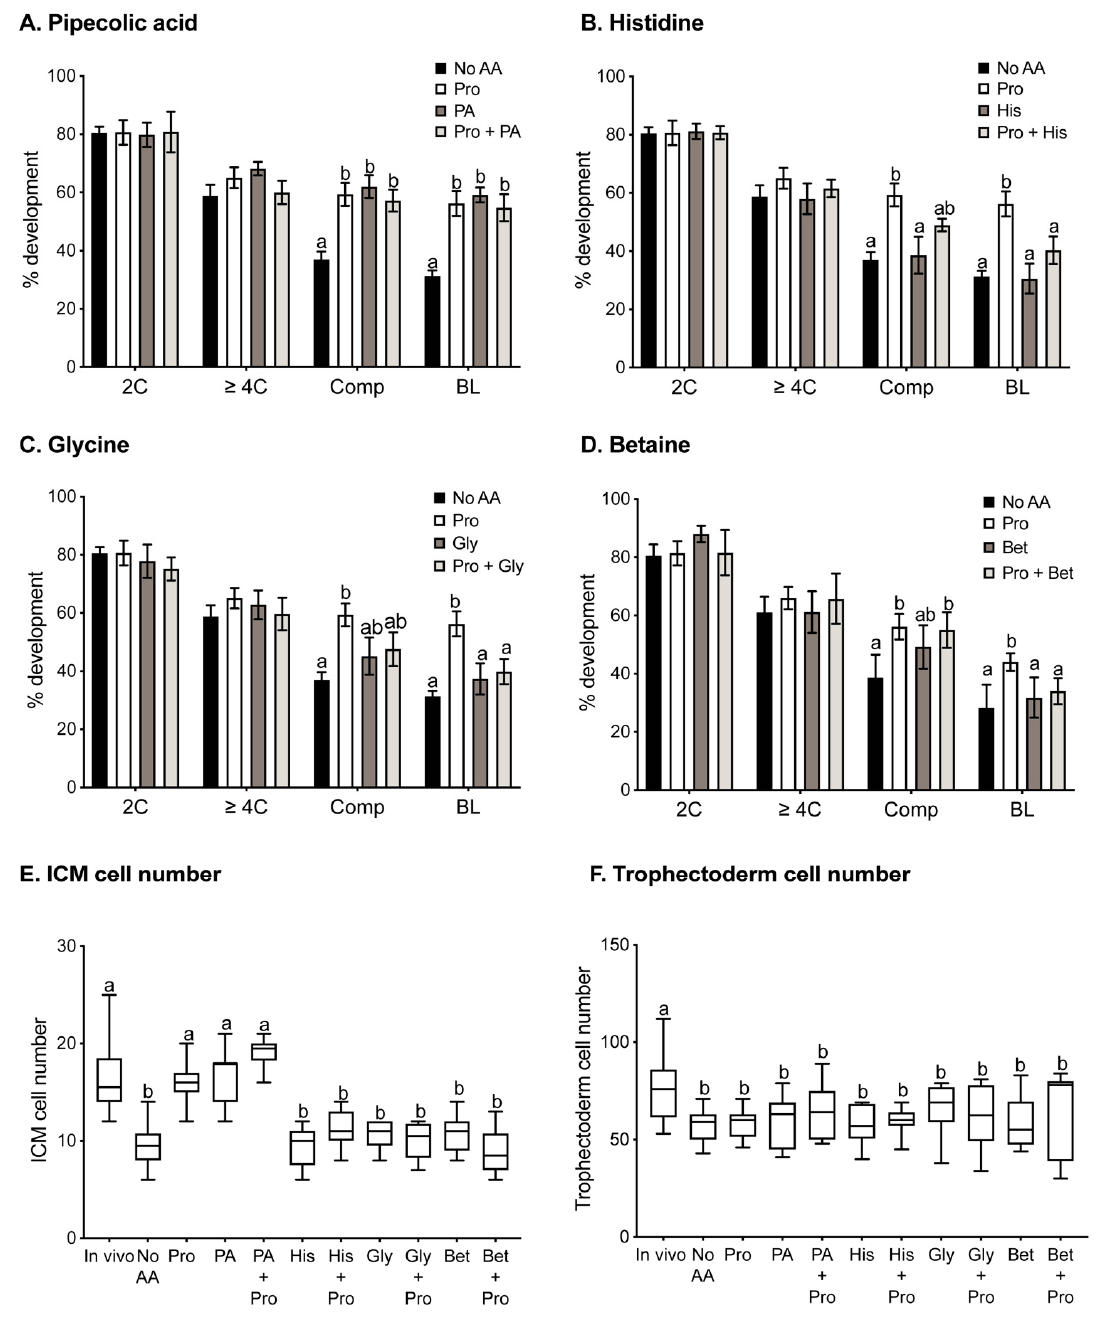
Figure 1. Preimplantation development following IVF in the presence of various amino acids. Fertilisation was performed in the absence of amino acids (No AA) or the presence of 0.4 mM Pro alone or 0.4 mM Pro in the presence of ( A ) 5 mM PA, ( B ) 5 mM His, ( C ) 5 mM Gly, or ( D ) 5 mM Bet. Following fertilisation, zygotes were cultured in mod-HTF in the absence of added amino acids for 120 h, and the percentages of embryos at the 2-cell (24 h), ≥ 4-cell (48 h), compacted (72 h), and blastocyst (120 h) stages were recorded. Bars represent mean ± SEM obtained from 3 independent experiments with a minimum of 10 zygotes per treatment group in each experiment. Blastocysts were fixed and stained with DAPI, and ICM ( E ) and trophectoderm ( F ) cell numbers were counted. Whiskers indicate highest and lowest values, and the mean is represented by the centre line in the box. Data were analysed using GraphPad Prism using 1-way ANOVA with Tukey’s multiple comparisons test ( A – D ) or Dunnett’s multiple comparison test ( E , F ). Bars sharing the same letter are not significantly different ( p >